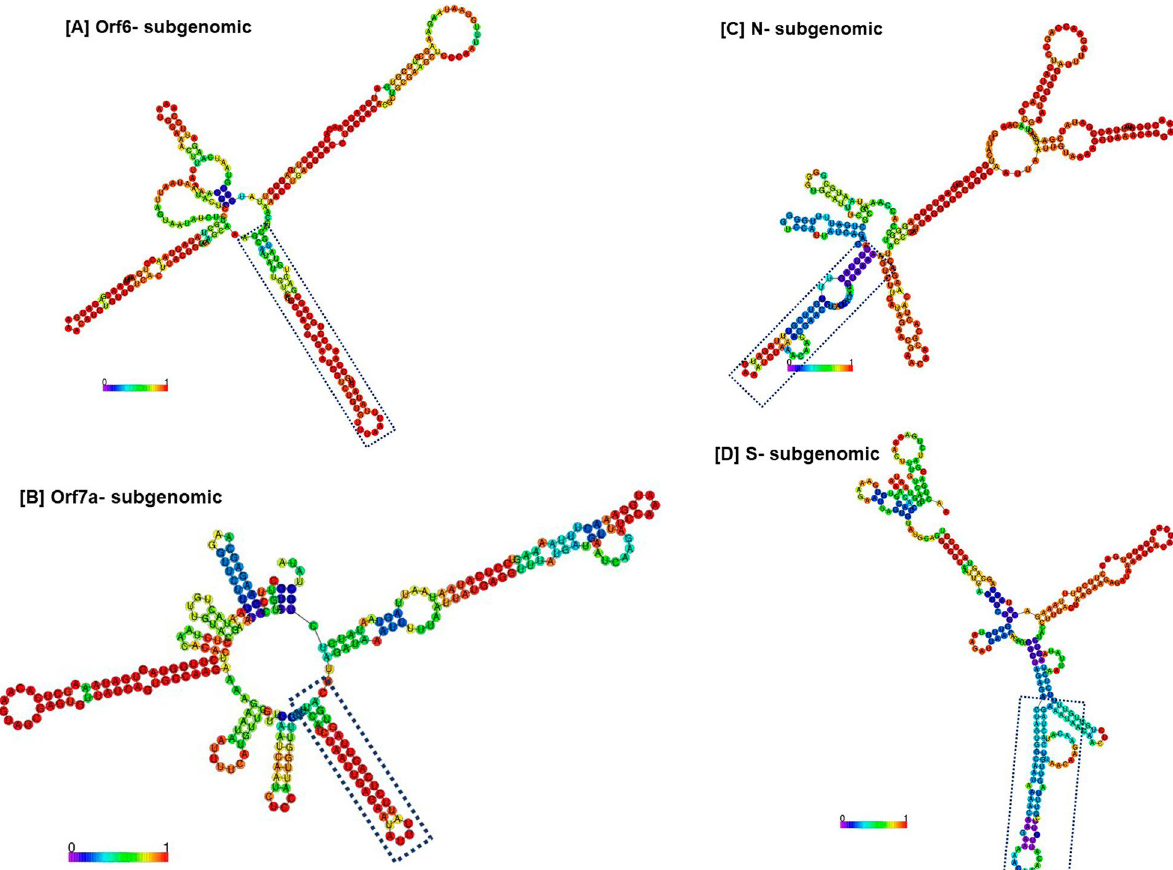
Fig. 3 The panel involves the secondary structures of representative subgenomic RNAs. The consensus secondary structure of respective subgenomic RNA (Orf6 subgenomic, Orf7a subgenomic, N subgenomic, and S subgenomic) is shown in a distinct box (dotted blue